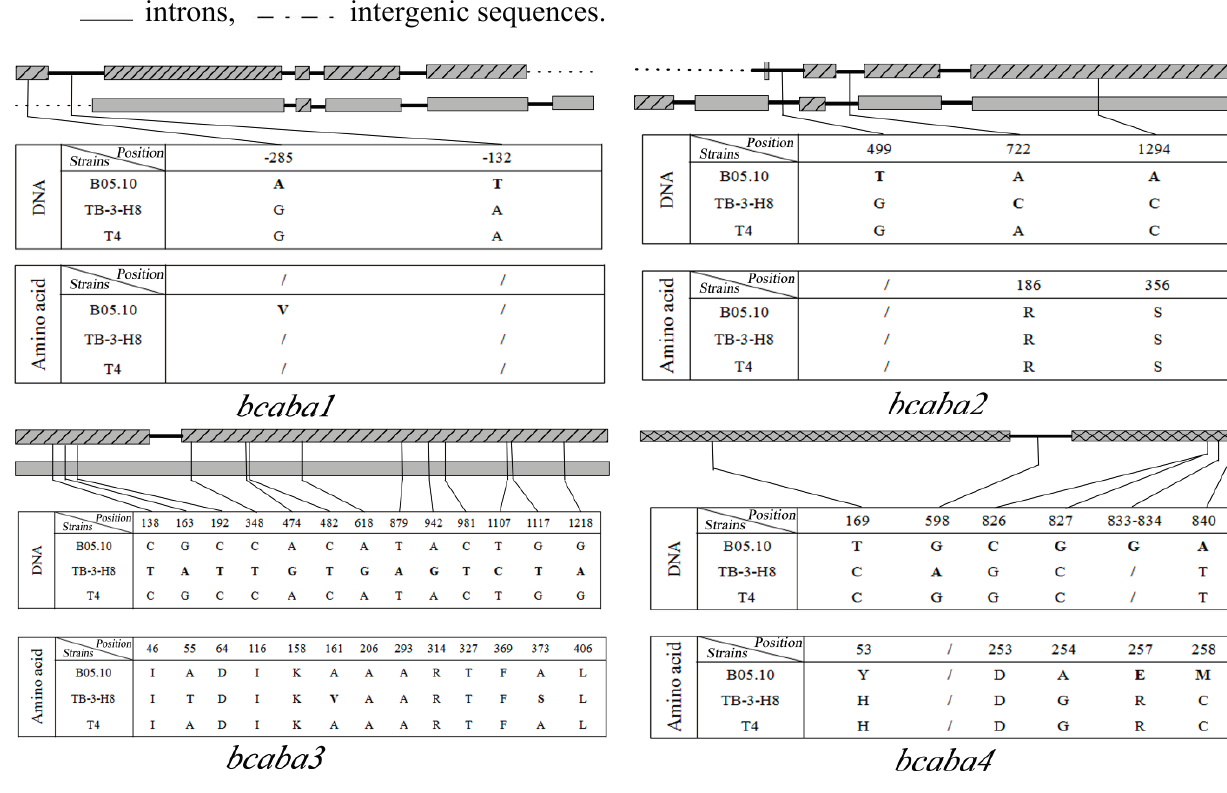
Figure 3. Structure of the ABA gene cluster ( bcaba1 , bcaba2 , bcaba3 and bcaba4 ) and comparison of SNPs among three strains. Sites in TB-3-H8 were used for standard positions of SNPs. Structure of genes in B05.10;